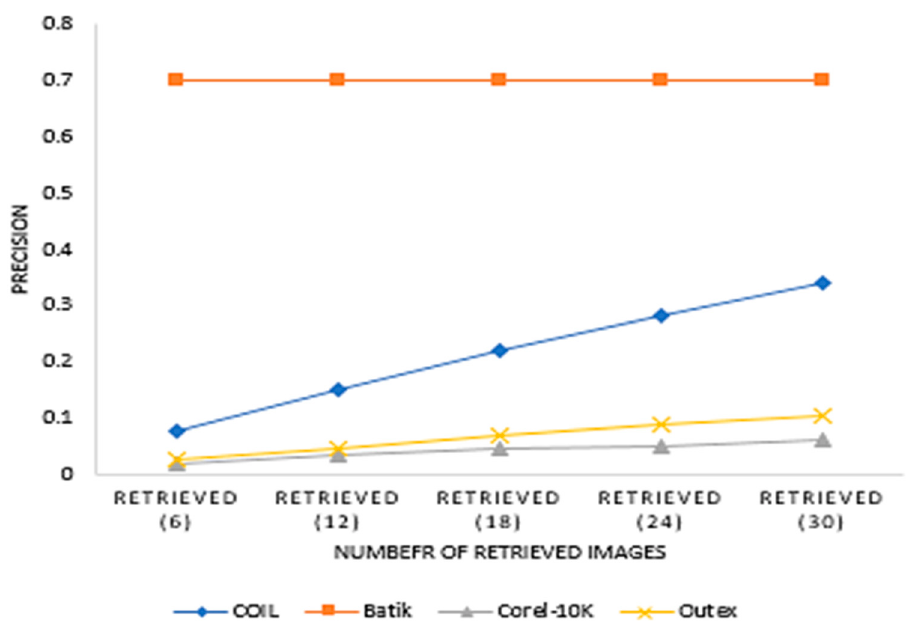
Figure 6. Average precision for various retrieved values for the four datasets.